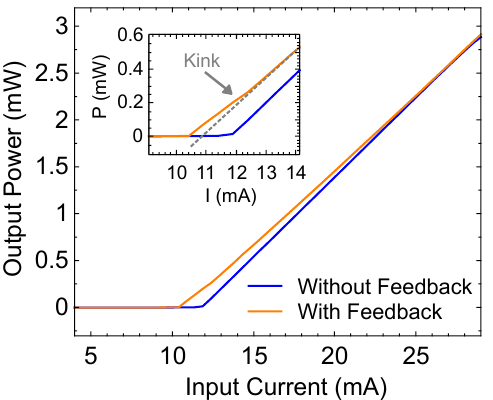
Figure 2. Power-current characteristics of a single-mode laser under different operation conditions: in solitary emission (blue line) and when subject to delayed optical feedback (orange line). The inset is a magnification of the region around the two distinct laser